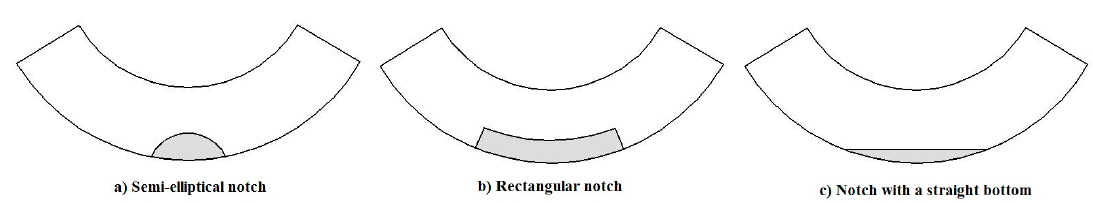
Figure 5. Notch type: ( a ) semi-elliptical notch; ( b ) rectangular notch [23], and ( c ) notch with a straight bottom [25].